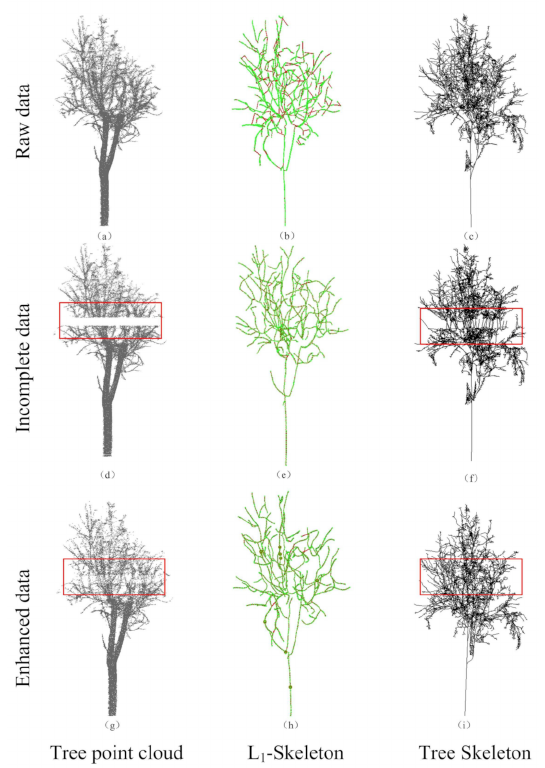
Figure 9. Comparison of Robinia pseudoacacia tree point clouds before and after deleting points. ( a ) is the original point cloud, ( b , c ) is the extracted skeleton structure; ( d ) describes the tree point cloud after deleting some points, ( e , f ) is the extracted skeleton structure; ( g ) represents the tree point cloud after iterative repair, ( h , i ) is the extracted skeleton structure.